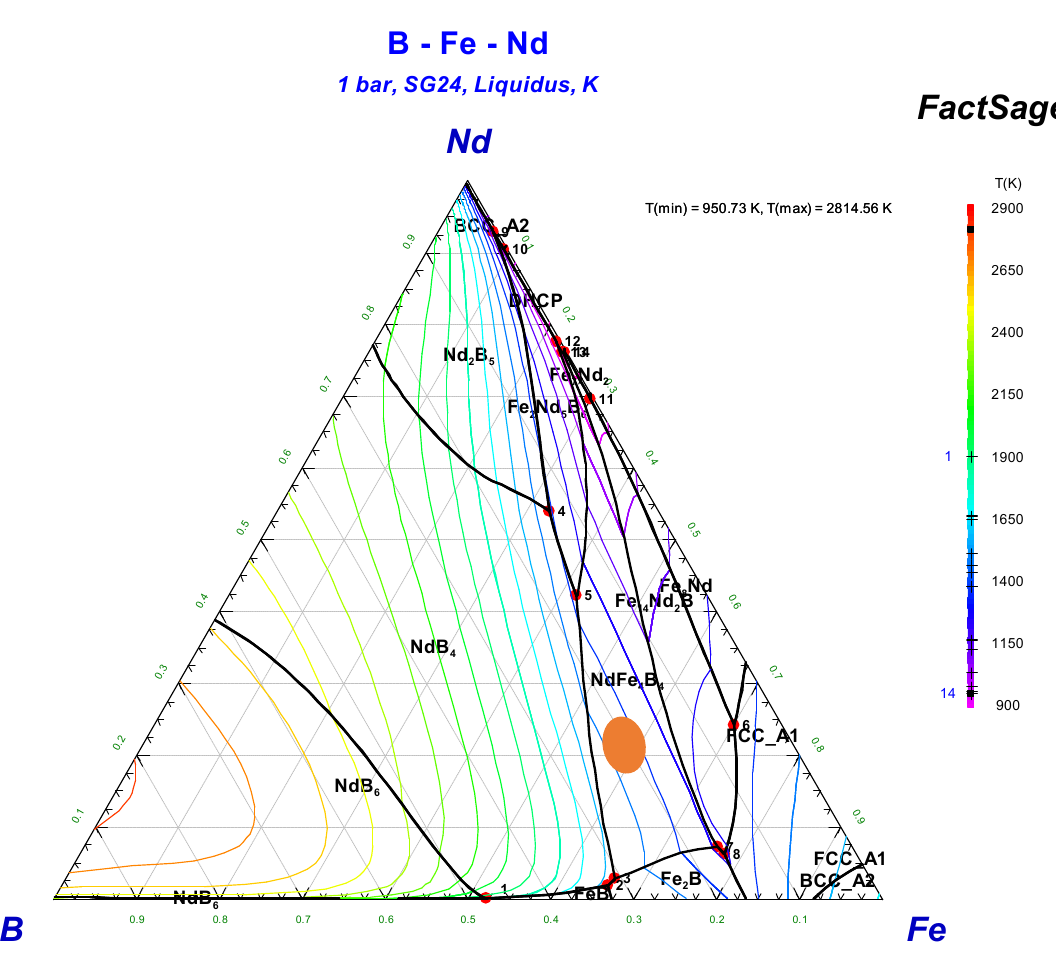
Figure 2. Ternary phase diagram of Nd-Fe-B system with liquidus temperature projection .